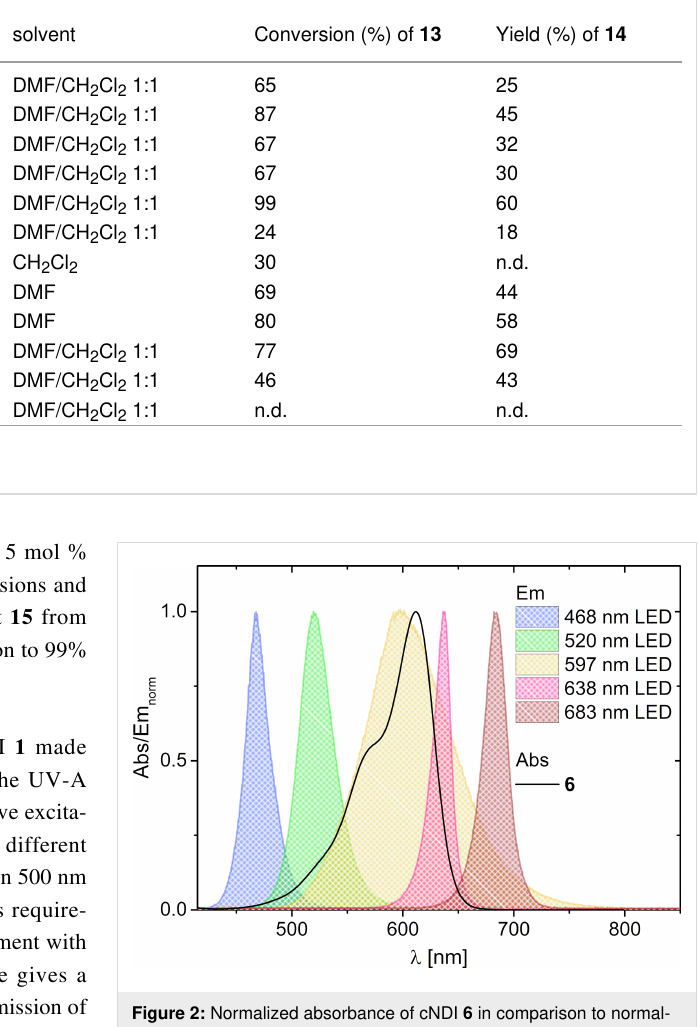
Table 2: Photoredox catalytic conversions of diethyl 2-bromomalonate ( 13 ) with 1-octanal ( 12 ) and yields of product 14 by different photoredox cata- lysts ( X ).